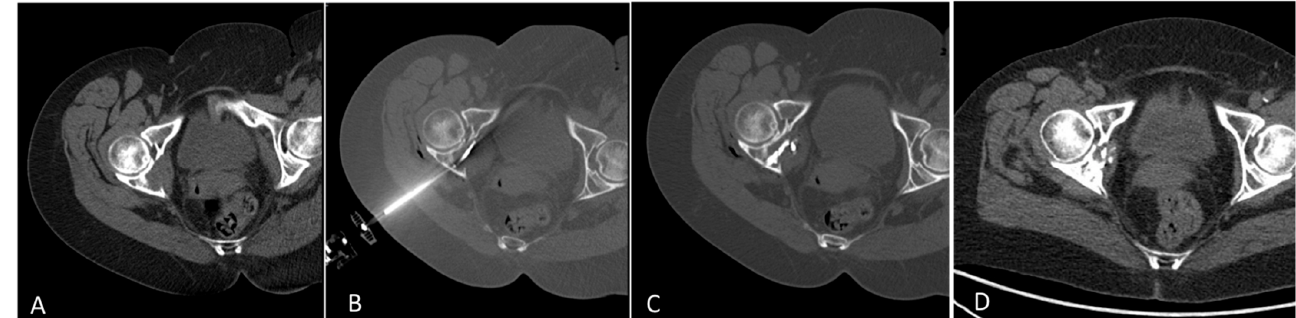
Figure 4. Treatment with tRFA and osteoplasty of an osteolytic metastasis of the posterior column of the right hip from breast cancer in a 65-year-old woman ( A ). Axial CT showed the placement of the steerable radiofrequency bipolar device (tSTAR) ( B ). Axial CT scan showed the metastases filled by PMMA ( C ). Axial CT after 12 months showed a partial recalcification of the posterior column of the hip and disappearance of the tumor mass ( D ).